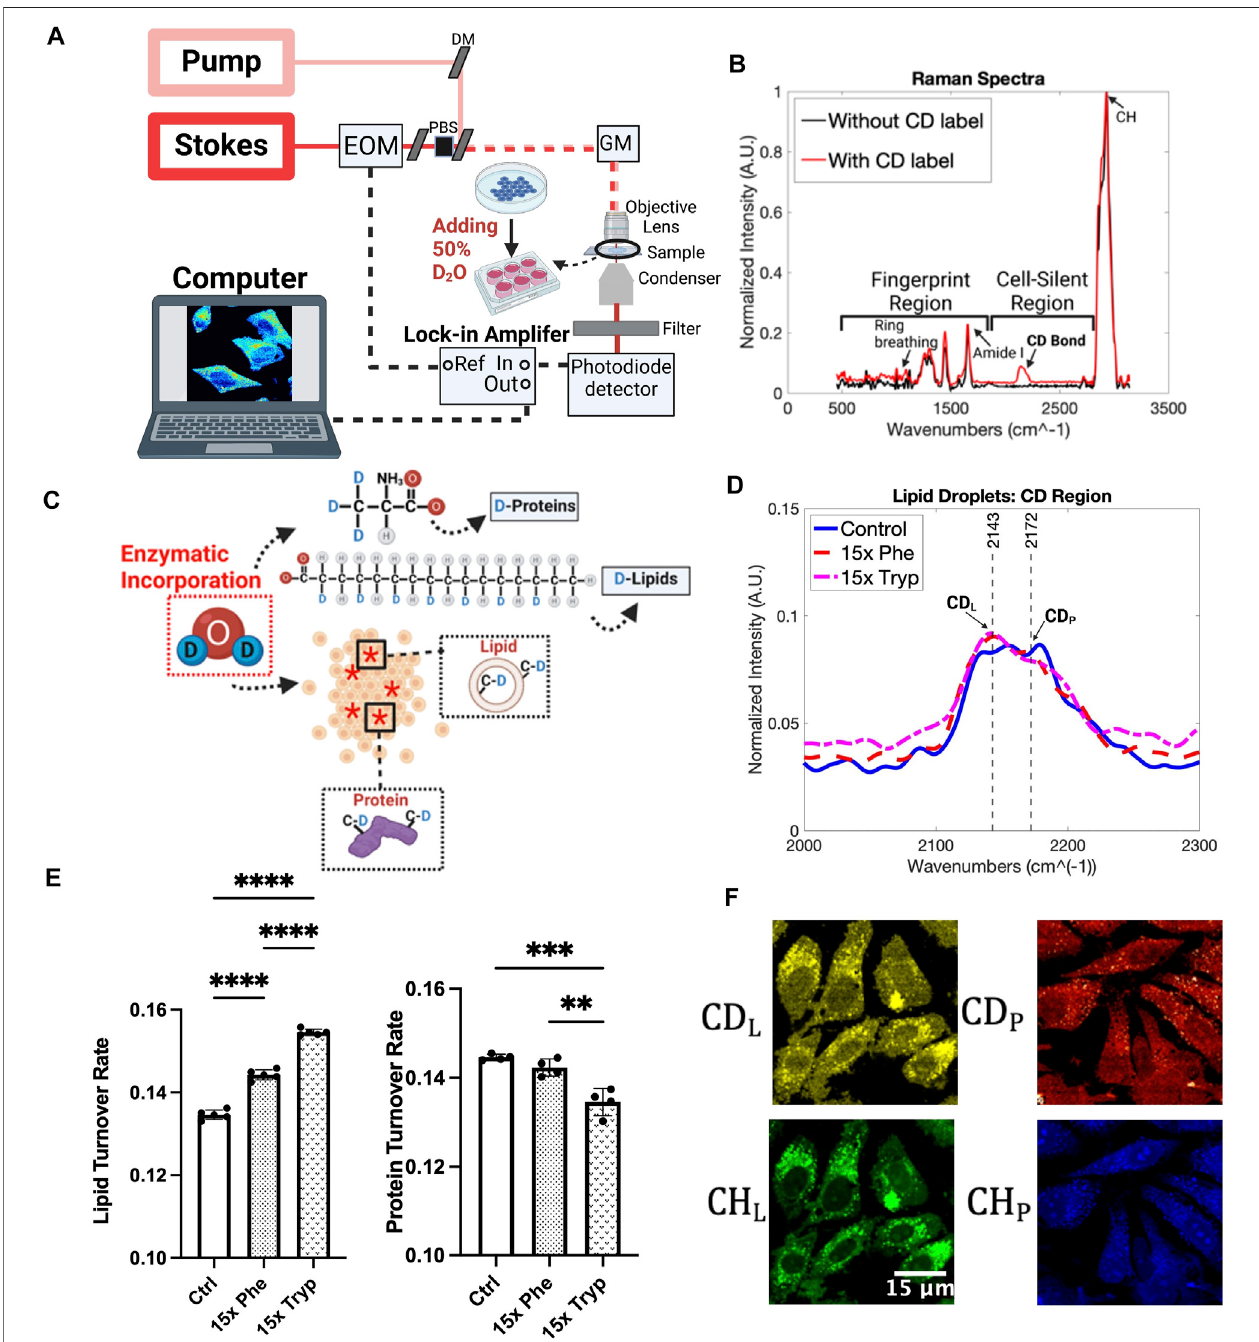
FIGURE 2 | DO-SRS microscopy and Spontaneous Raman spectra. (A) Schematic diagram of the experimental setup SRS system work fl ow (Li et al., 2017). Abbreviations: DM (dichroic mirror), EOM (electro-optical modulator), PBS (polarizing beam splitter), GM (galvometer mirror). (B) Spontaneous Raman spectra without D 2 O incorporation (black) and 50% of D 2 O addition (red). (C) Magni fi cation of how HeLa cells were treated with D 2 O and excess aromatic amino acids, Phenylalanine (Phe)andTryptophan(Tryp).RedasterisksrepresenttheeffectofD 2 Otothecells. (D) ResultsfromprocessedSpontaneousRamanspectrumsforthecontrol(Ctrl) group (blue), 15x Phenylalanine-treated (15x Phe) group (red), and 15x Tryptophan-treated (15x Tryp) group (magenta) from HeLa cells. Spectrums were taken with the laser focused on structures that resembled lipid droplet organelles under the bright fi eld imaging system. Each Raman spectrum had a background spectrum from the PBS removed before being normalized, averaged, and baseline corrected. Peaks labeled correspond to Deuterium-labelled lipid (CD L ) and Deuterium-labelled protein (CD P ) (Yamakoshi et al., 2011; Shi et al., 2018a; Shi et al., 2018b; Zhang et al., 2019; Zhao et al., 2020), which were observed more speci fi cally tounderstand how 50% D 2 Ocellmediawiththeexcessaromaticaminoacidsaffectedthelipidmetabolicactivity. (E) Quanti fi cationofthemeanRamanresultsfromCD L andCD P peaksforHeLa under control and experimental conditions. **** p < 0.0001, *** p < 0.001, ** p < 0.01 from 2 way ANOVA test. (F) DO-SRS images of HeLa cells in C-D lipid (2145 cm − 1 ) and C-D protein (2175 cm − 1 ) on the top row. Bottom row shows SRS images of cells in the protein and lipid channels from 2940 cm − 1 and 2845 cm − 1 .